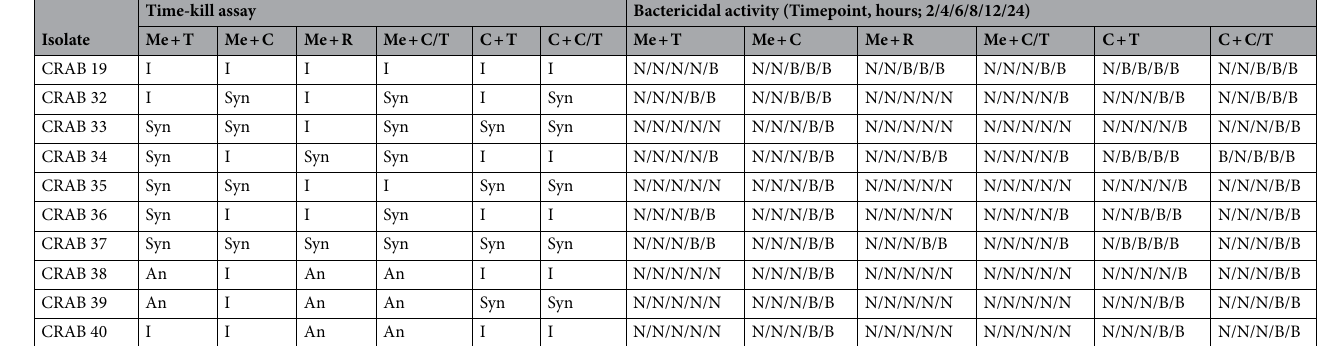
Table 4. Results of time-kill assay and bactericidal activity of two-drug combinations (1 × MIC) against each Acinetobacter baumannii isolate. An antagonism, B bactericidal, C colistin, C/T ceftolozane/tazobactam,